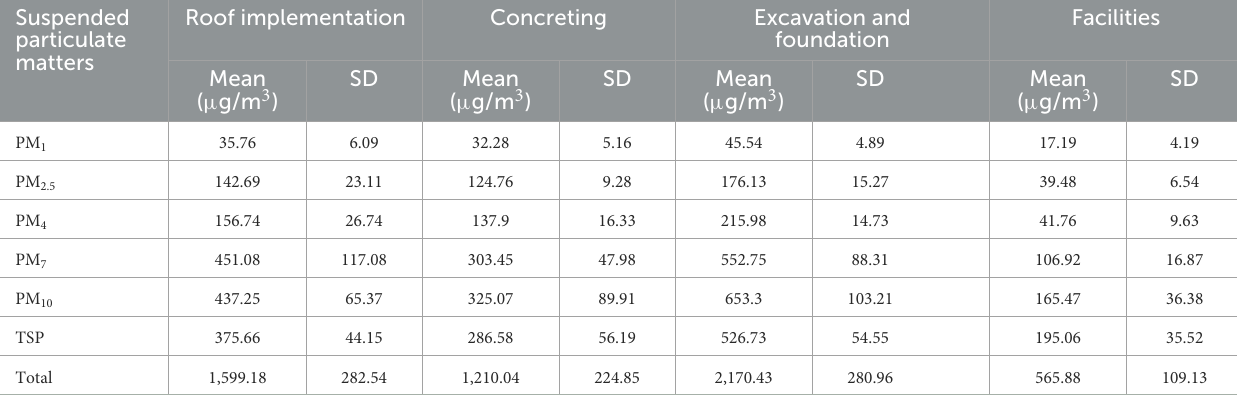
TABLE 1 Average mass concentration of suspended particulate matters in different stages of construction in terms of micrograms per cubic meter. Suspended